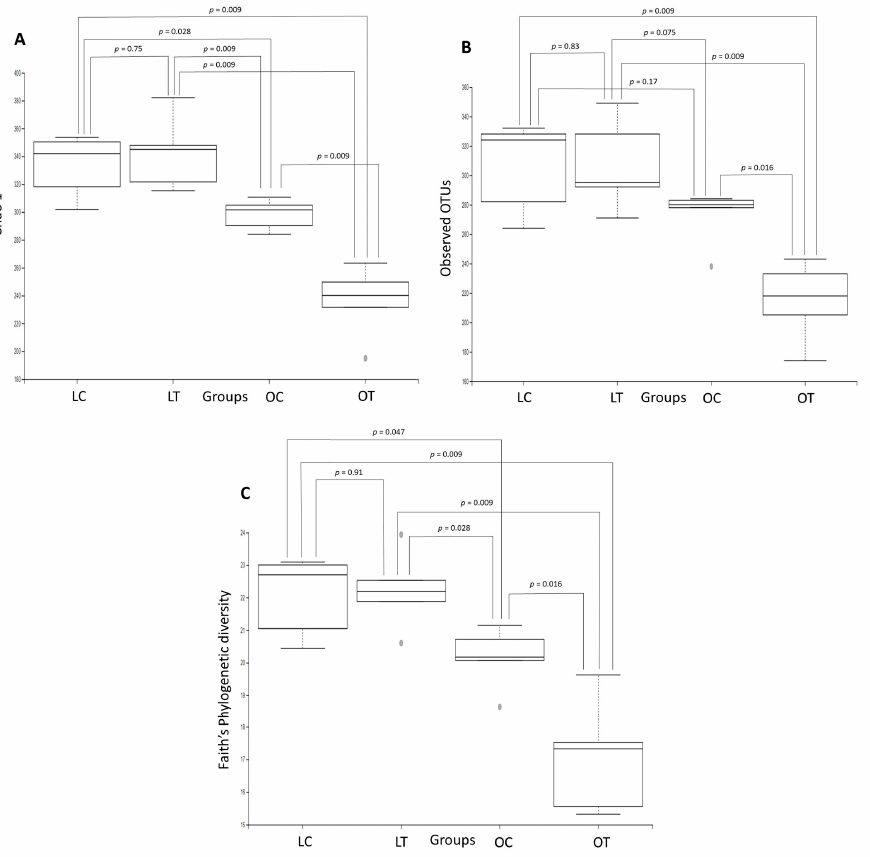
Figure 2. Comparison of the gut microbiota structures in the lean control (LC), lean treated (LT), obese control (OC) and obese treated (OT) groups. Boxplots showing the Chao1 index ( A ), observed OTUs ( B ) and Faith’s phylogenetic tree ( C ) were constructed to evaluate microbiome diversity. The plots revealed that the samples were clustered according to their bacterial composition. PERMANOVA indicated a significant difference in beta diversity between the groups (Bray Curtis: lean control vs. lean treated ( p = 0.012), lean control vs. obese control ( p = 0.010), lean control vs. obese treated ( p = 0.008), lean treated vs. obese control ( p = 0.009) and lean treated vs. obese treated ( p = 0.008). No significant difference was observed between the obese control vs. obese treated groups ( p = 0.111) (Figure 3A). Unweighted UniFrac: lean control vs. lean treated ( p = 0.012), lean control vs. obese control ( p = 0.010), lean control vs. obese treated ( p = 0.008), lean treated vs. obese control ( p = 0.009) and lean treated vs. obese treated ( p = 0.008). No significant difference was observed between the obese control vs. obese treated groups ( p = 0.111) (Figure 3B). Weighted UniFrac: lean treated vs. obese control ( p = 0.008) and lean treated vs. obese treated ( p = 0.019). No significant difference was observed between the lean control vs. lean treated ( p = 0.15), lean control vs. obese control ( p = 0.209), lean control vs. obese treated ( p = 0.078) or obese control vs. obese treated ( p = 0.61) groups (Figure 3C). Jaccard: lean control vs. lean treated ( p = 0.009), lean control vs. obese control ( p = 0.011), lean control vs. obese treated ( p = 0.012), lean treated vs. obese control ( p = 0.008), lean treated vs. obese treated ( p = 0.006) and obese control vs. obese treated ( p = 0.009) (Figure 3D).